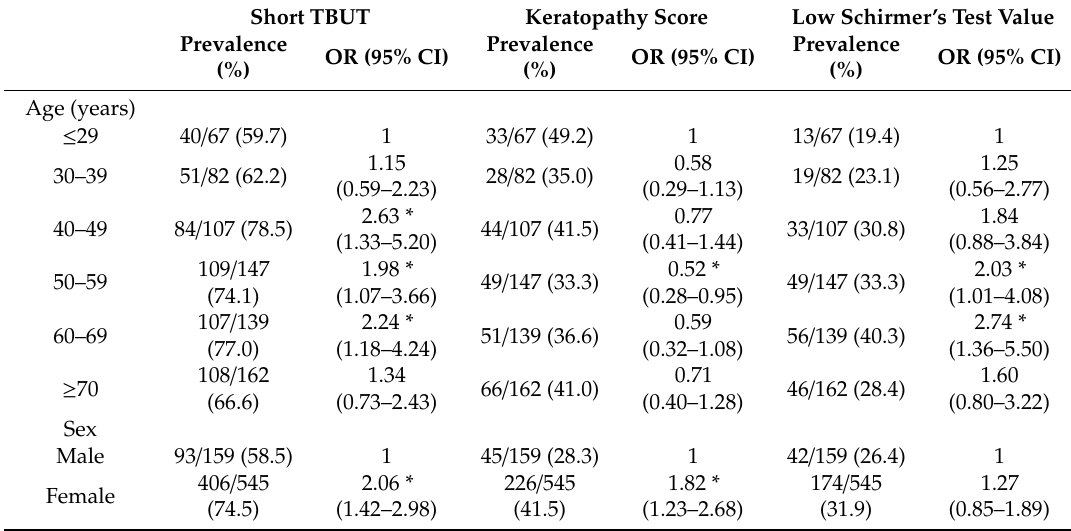
Table 3. Association between demographic characteristics and corneal signs.